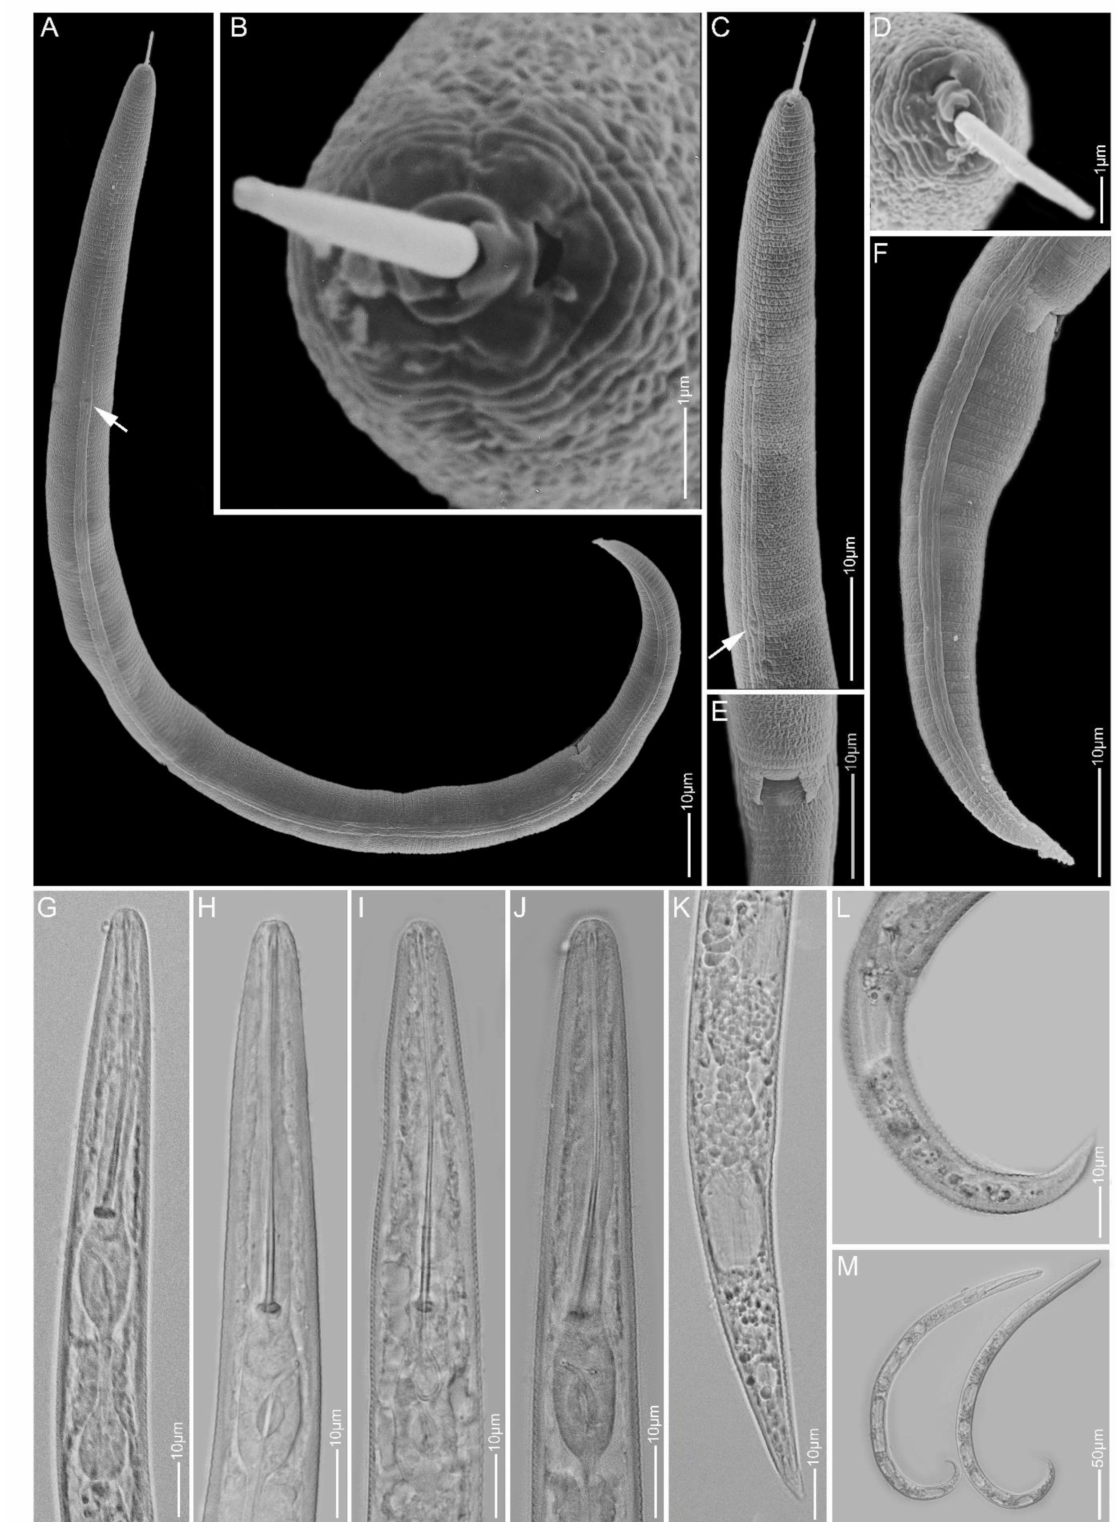
Figure 10. Light and scanning electron microscopy images of Paratylenchus straeleni females: ( A ) whole body; ( B , D ) face view; ( C , G – J ) anterior region; ( E ) vulva region; ( F , K , L ) tail region; ( M ) total body; arrows pointed to deirids in ( A , C